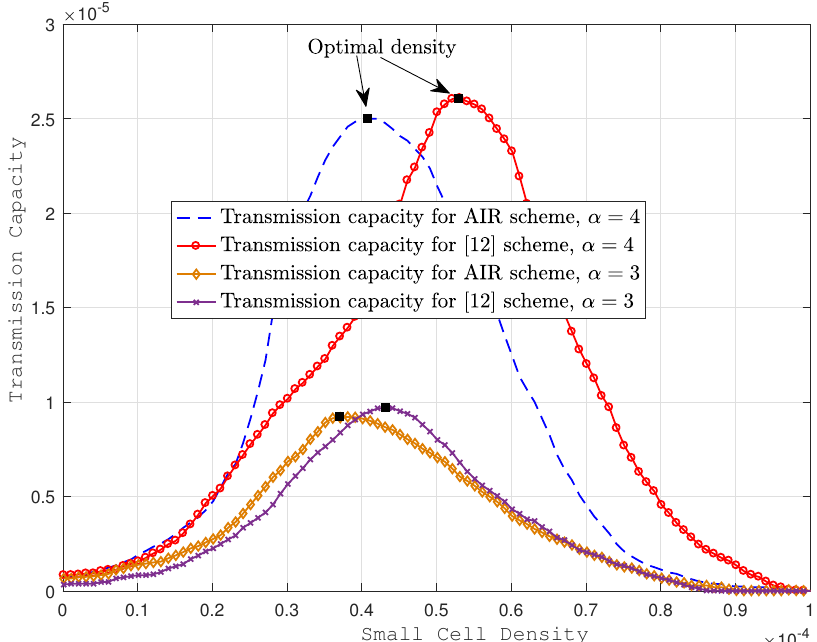
Figure 9. Transmission capacities for optimal deployment of various